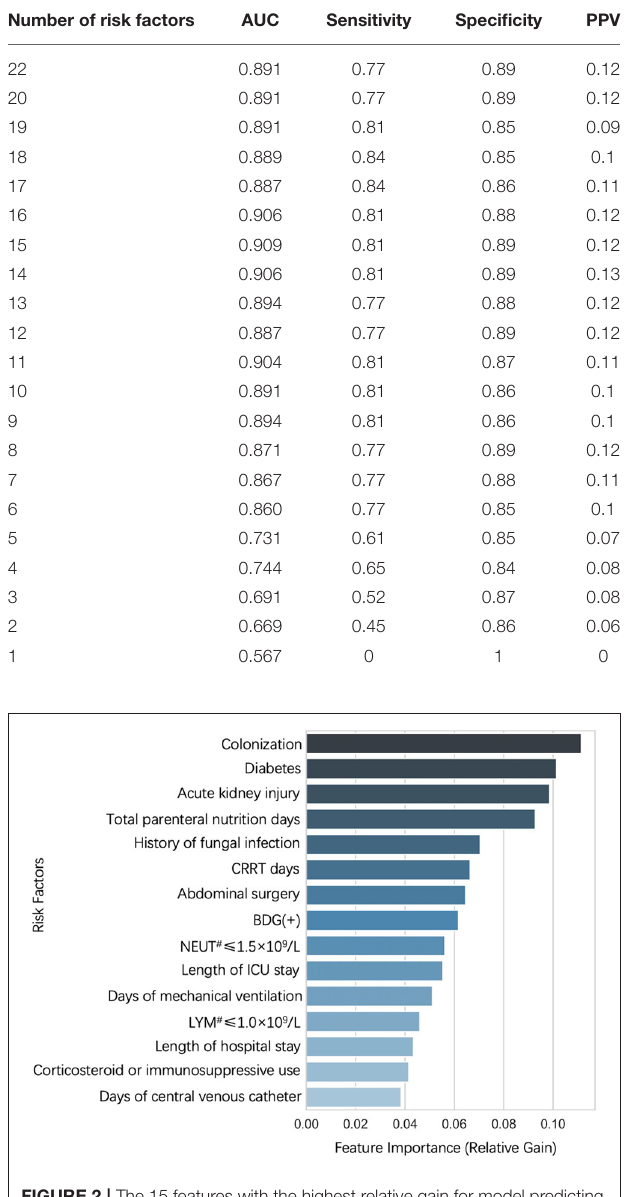
TABLE 3 | Efficiency of XGBoost model with different number of risk factors. Number of risk factors AUC Sensitivity